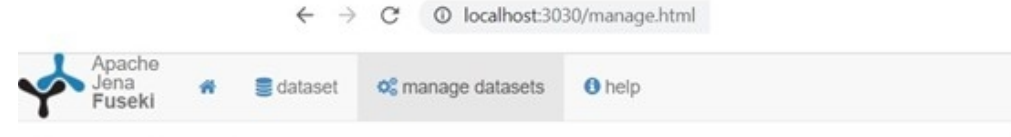
Figure 20. Integration of TDB with Jena Fuseki for ontology store in the “ttl” format and